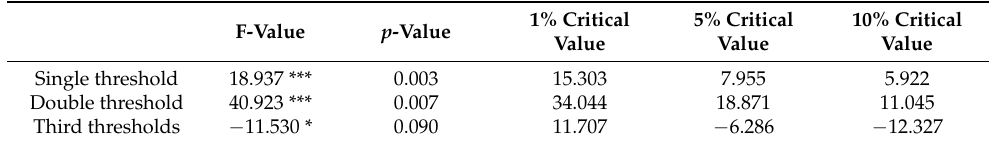
Table 5. Threshold effect